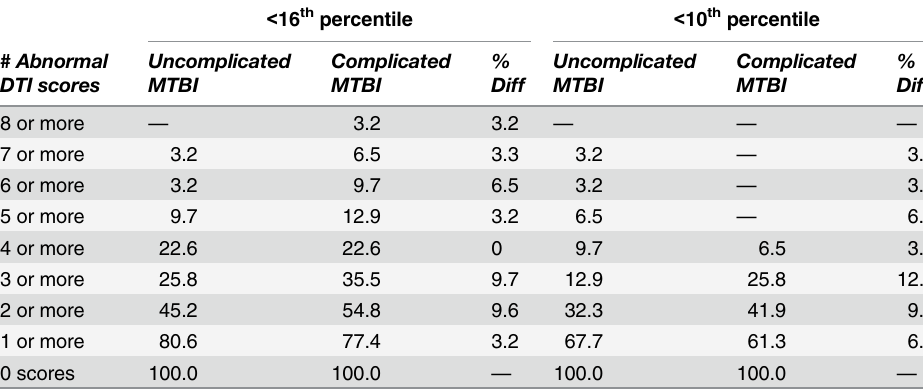
Table 6. Base rate of low scores by group: Individual NAB tests.